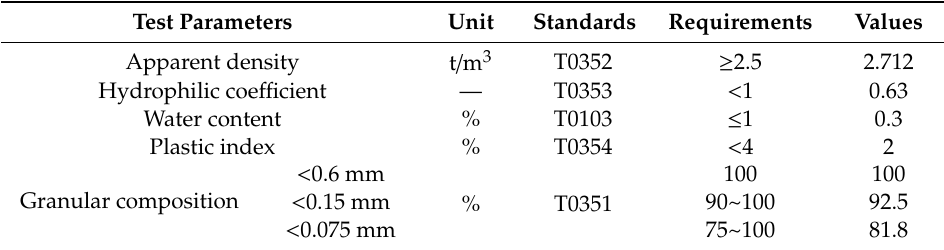
Table 4. Technical properties of limestone mineral